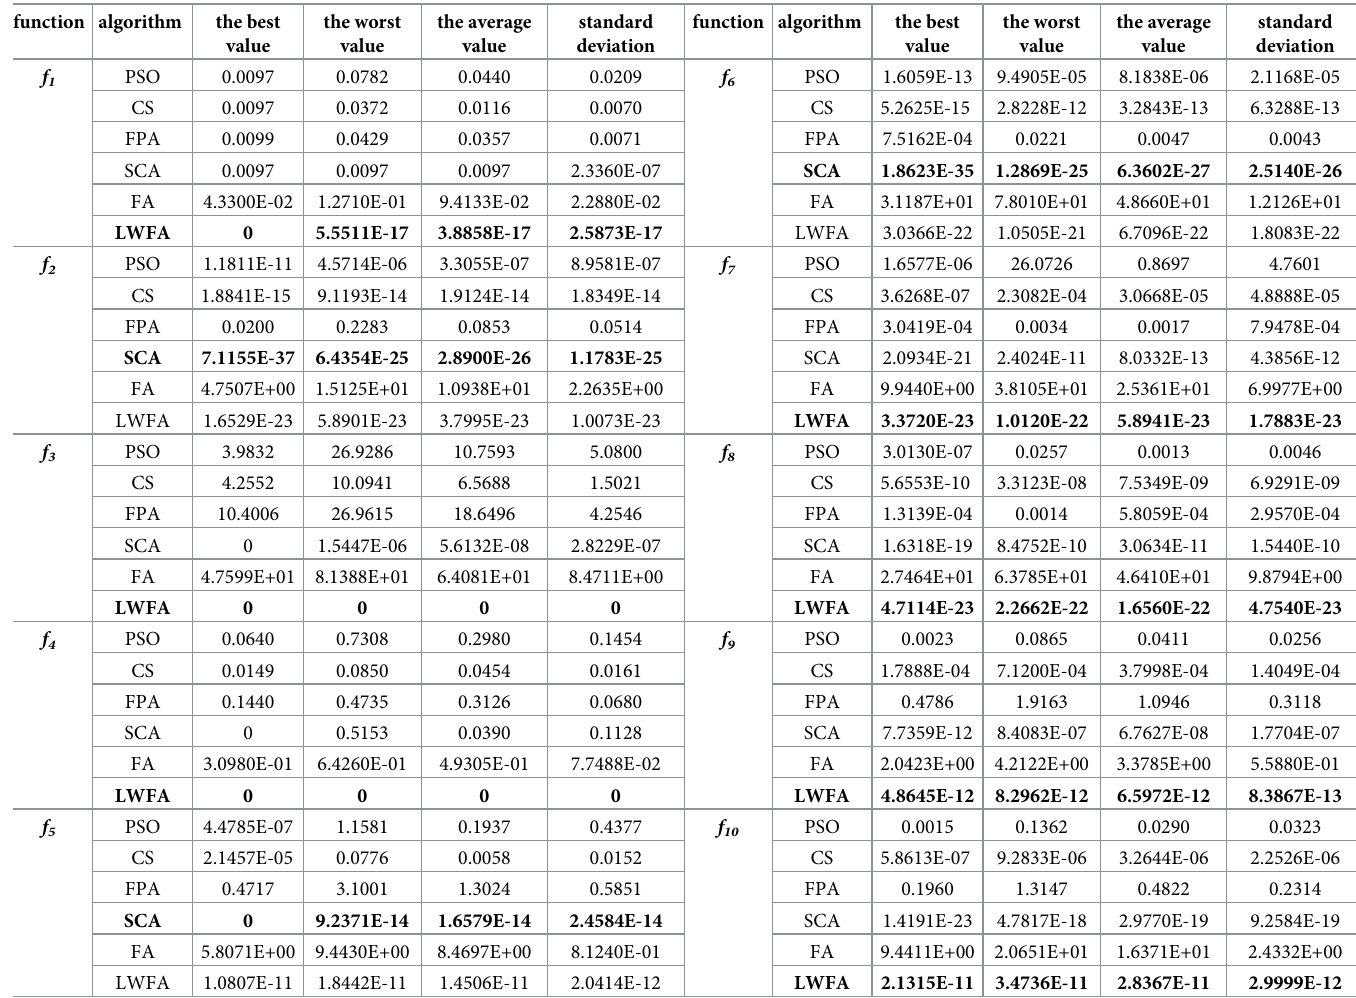
Table 5. The optimization result of 10 benchmark functions for different algorithms (D =